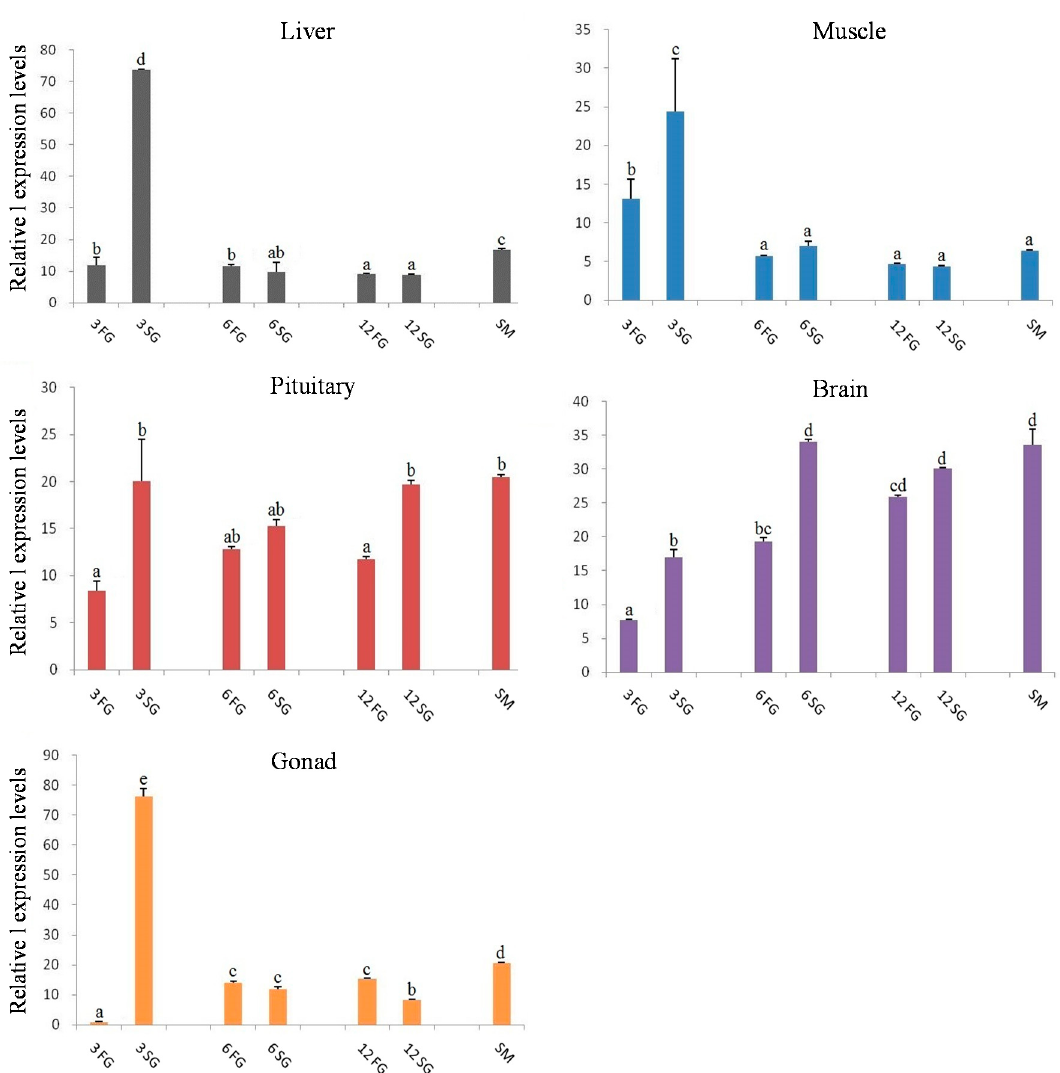
Figure 8. The relative expression levels of let-7a in different tissues from different growth stages of M. amblycephala . 3FG, fast-growth individuals at 3 months old; 3SG, slow-growth individuals at 3 months old; 6FG, fast-growth individuals at 6 months old; 6SG, slow-growth individuals at 6 months old; 12FG, fast-growth individuals at 12 months old; 12SG, slow-growth individuals at 12 months old; SM, mature individuals. Values with the same letter mean no significant difference ( p > 0.05).